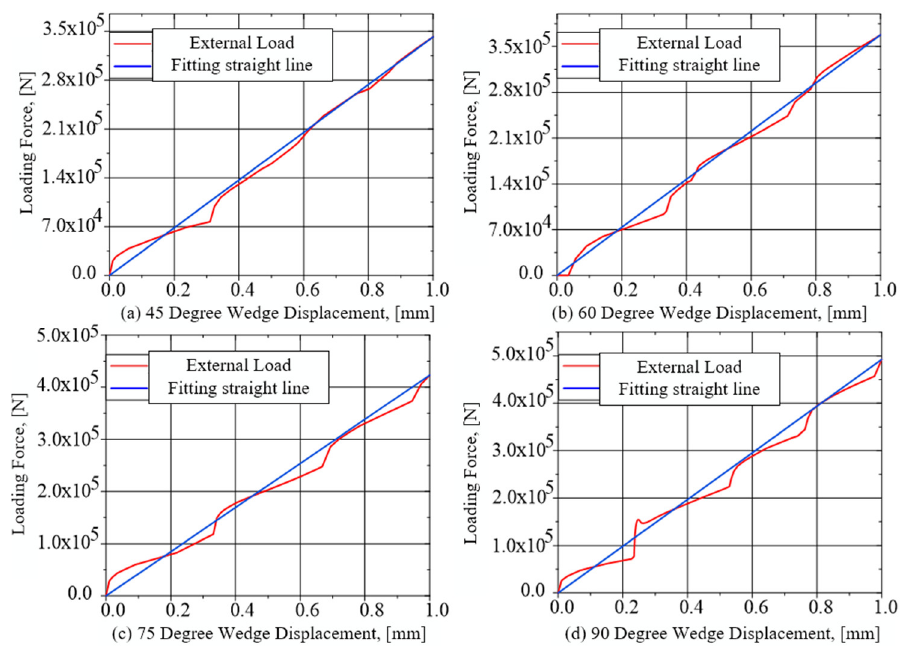
Figure 13. Change of Loading Force and Displacement during Wedge Embedding with 45°, 60°, 75° and 90° Tooth Angle.